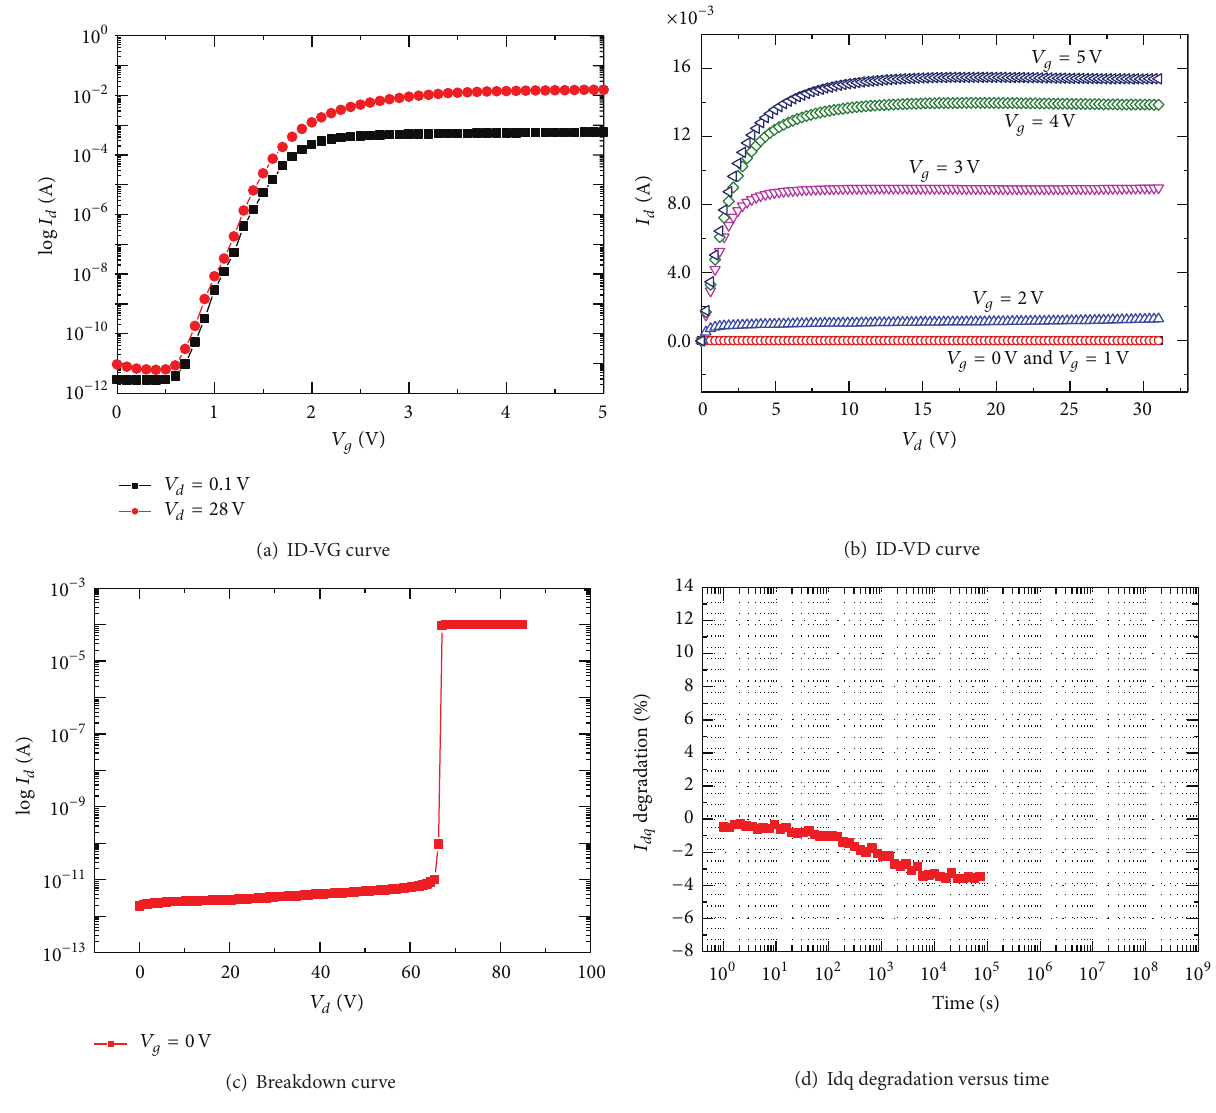
Figure 4: DC characteristics of W-sinker RF LDMOS device ( 𝑊 = 80